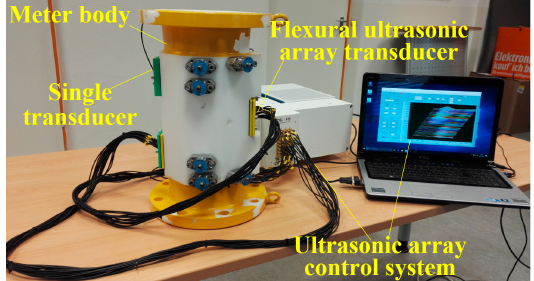
Figure 4. The prototype for the ultrasonic flow meter, where the control system digitizes, records, and processes the ultrasonic signals.